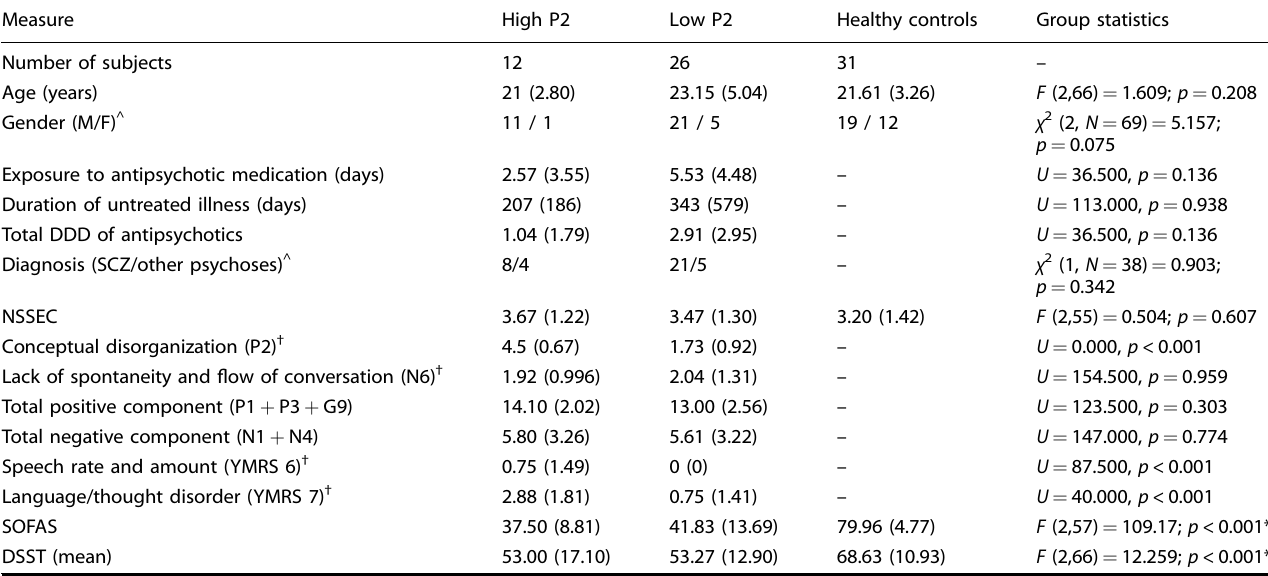
Table 1. Demographic and clinical characteristics of the sample.